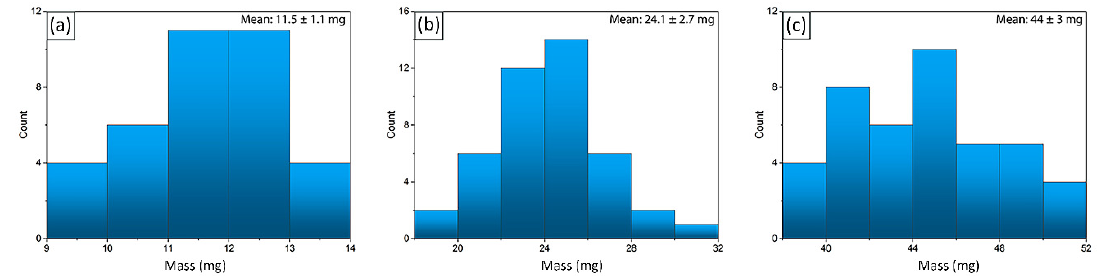
Figure 7. Histogram of mass distributions of Cu/CS spherical composites with ( a ) 25 µL; ( b ) 50 µL; ( c ) 100 µL of chitosan solution added in aqueous carbonic acid.